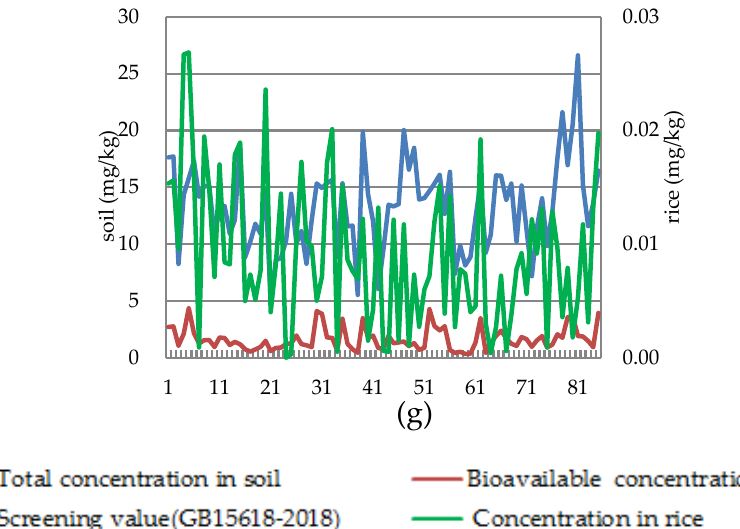
Figure 1. PTEs concentrations (mg/kg) in soil (total and bioavailable) and in rice from 85 sampling sites in Hunan, China. ( a ) Cd, ( b ), Pb, ( c ) Cu, ( d ) Zn, ( e ) Hg, ( f ) Mn, and ( g ) Co.